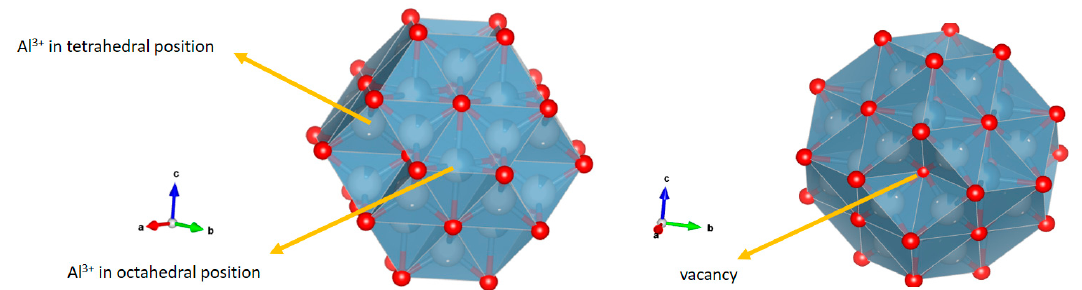
Figure 6. Polyhedral structure of γ -alumina. The red circles represent oxygen atoms, and the white circles represent the K + cations. Al 3 + atoms are in tetrahedral and octahedral coordination. The polyhedral structure was created in Vesta software based on 9001364 CIF obtained from the Crystallography Open Data Base.